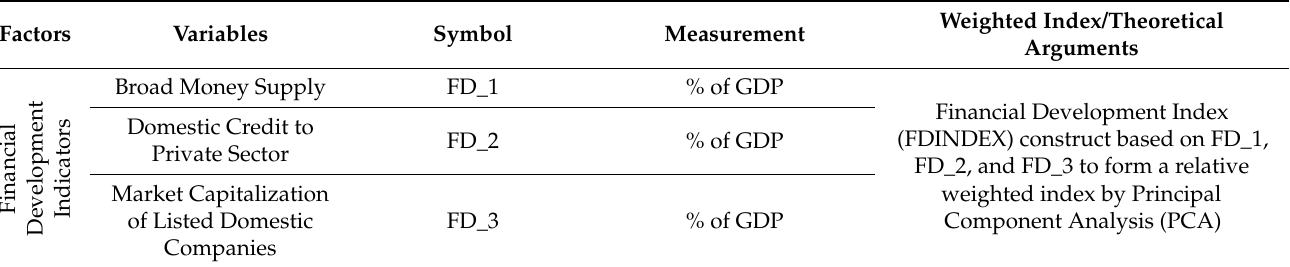
Table 2. List of